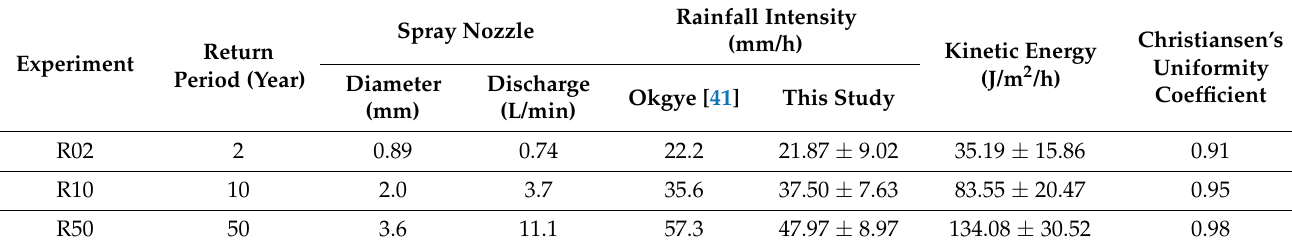
Table 1. Rainfall intensity and kinetic energy of simulated